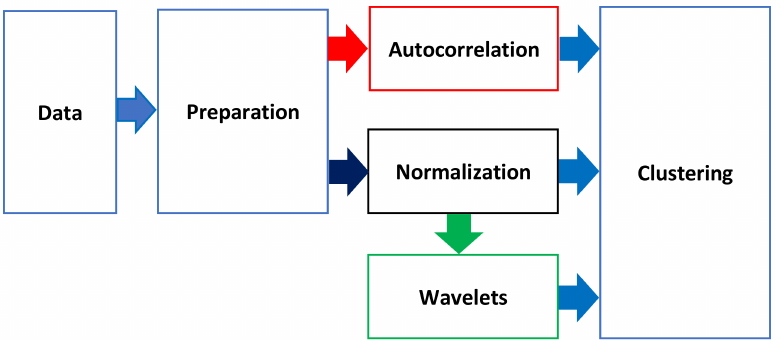
Figure 2. Methodology flow chart. This chart illustrates the different data processing methods applied. The (blue) boxes indicate processes to which all methods were applied, namely data , preparation and clustering . After preparation, autocorrelation (red) indicates the extraction of autocorrelation features. Normalization (black) was applied both as a sole processing method, but also in preparation for wavelet transformation